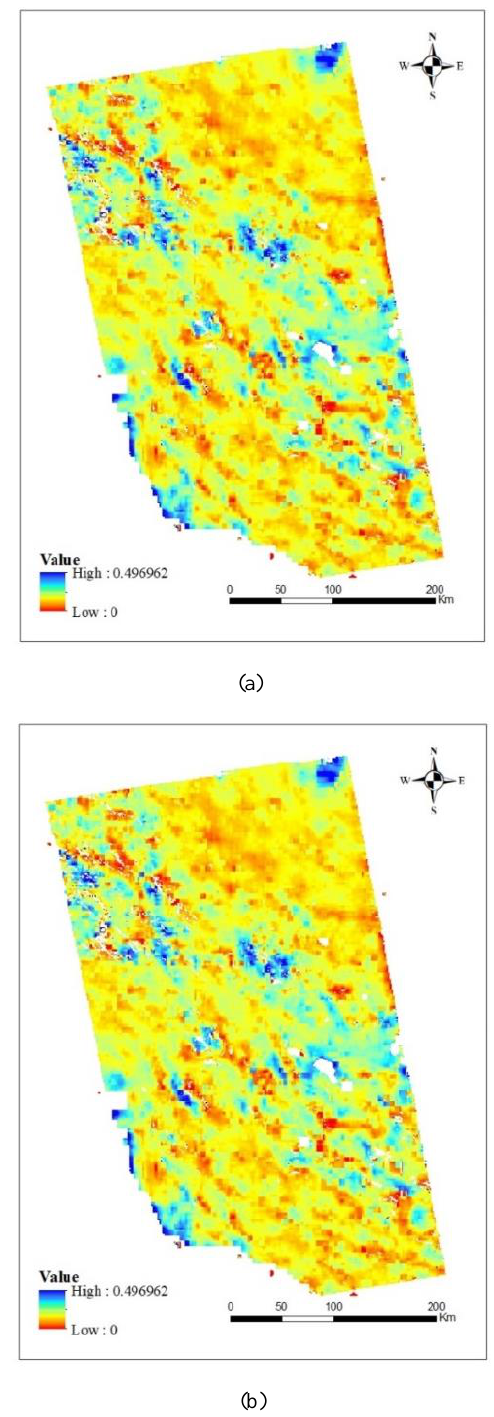
Figure 4 . (a) 1 km SMAP soil moisture product downscaled using regression method with Sentinel 3 data and (b) 1 km